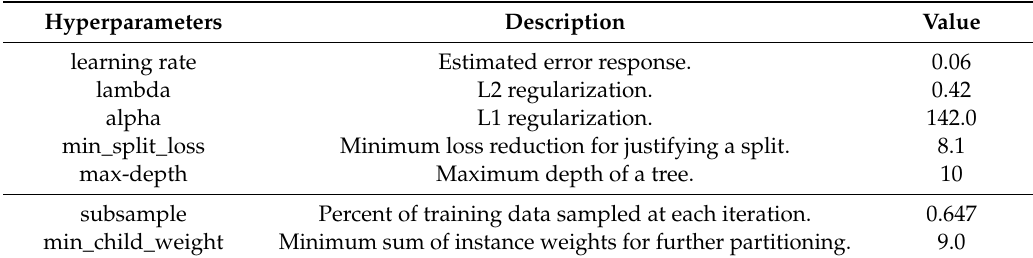
Table 7. Tuned eXtreme Gradient Boosting (XGBoost)